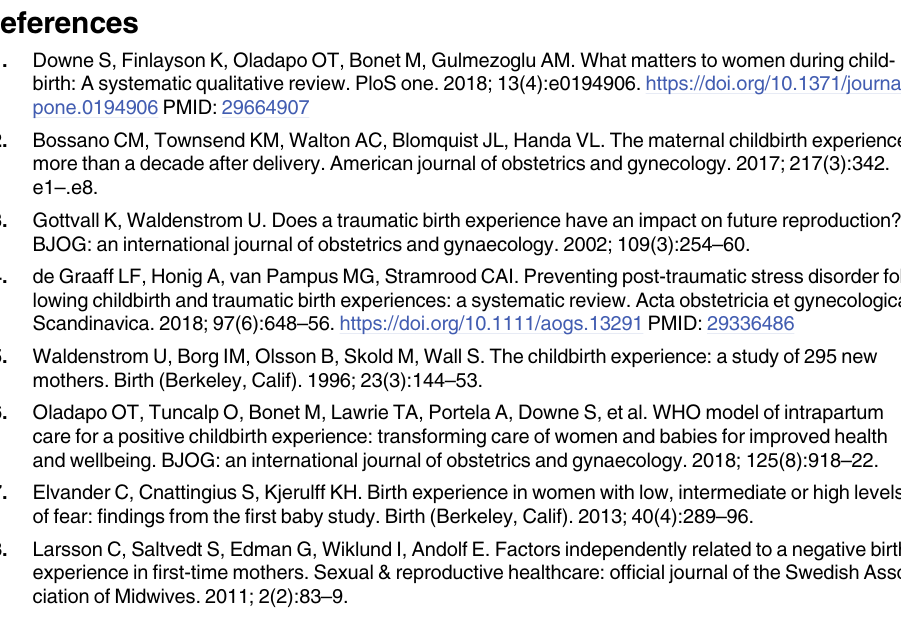
S1 Table. Maternal characteristics by planned mode of delivery in 2 nd birth. S2 Table. Mean difference of birth experience by planned mode of delivery in 2 nd birth, lin- ear regression. S3 Table. Odds of negative birth experience by planned mode of delivery in 2 nd birth, logis- tic regression. S4 Table. Maternal characteristics by registered birth experience in 2 nd